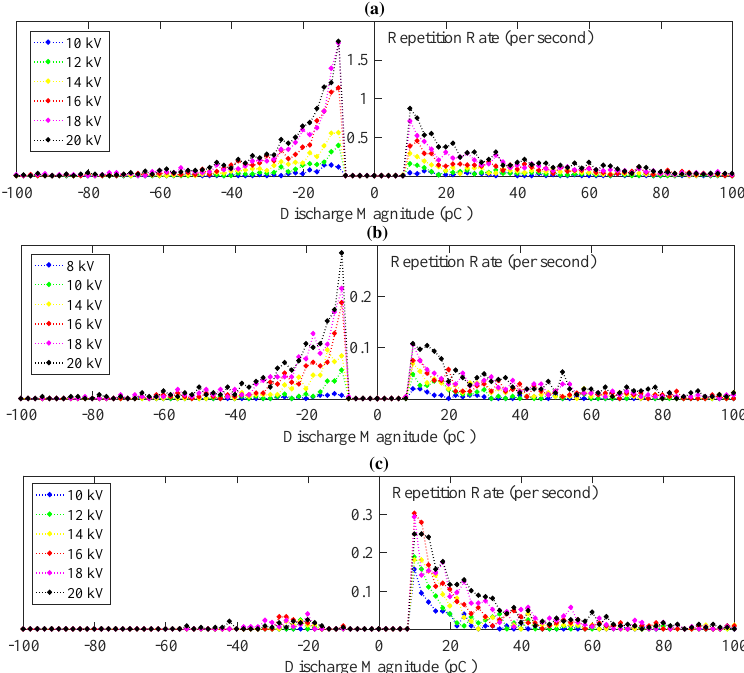
Figure 8. Voltage dependence of PD discharge magnitude versus repetition rate for ( a ) 0.1Hz; ( b ) 0.01Hz; ( c ) DC.